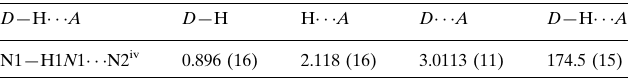
Hydrogen-bond geometry (A˚ , (cid:1)